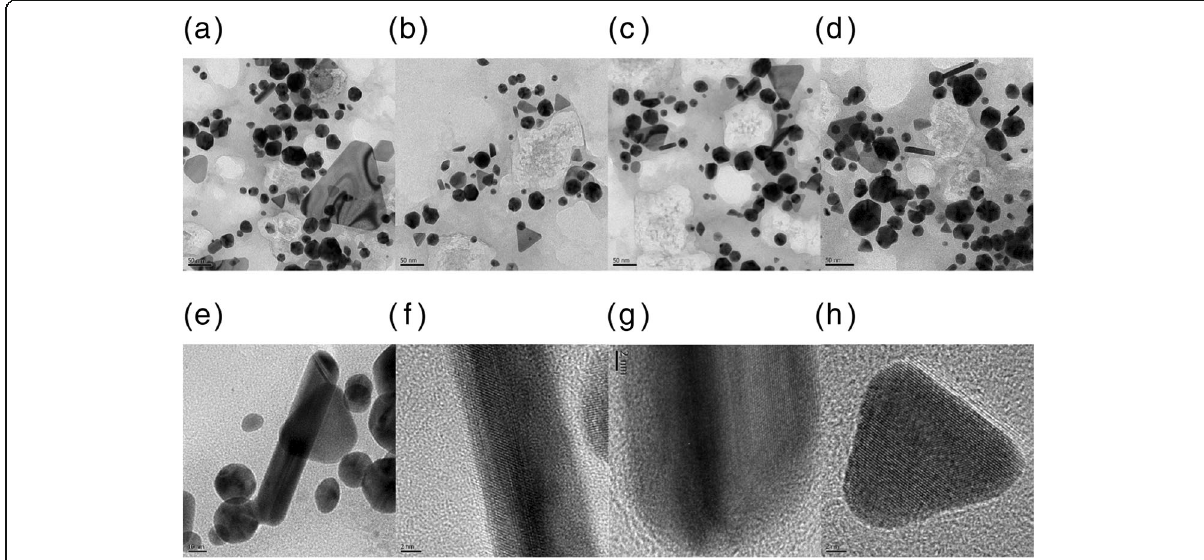
Fig. 4 HR-TEM Images of PV-AuNPs. The scale bar represents a 50 nm, b 50 nm, c 50 nm, d 50 nm, e 10 nm, f 2 nm, g 2 nm, and h 2